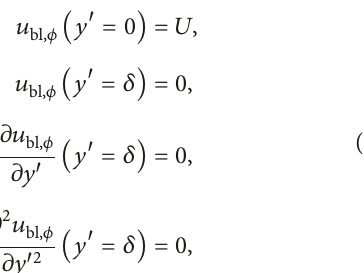
Figure 7 as thin boundary layer overflows a section of low fluid velocities without significant disturbances. However, at the leading edge of downstream pad significant velocity gradients occur. Therefore, maximum pressure within this region is located in the upper right corner comparable to lid driven cavity flow. Black arrows indicate the mayor flow directions in Figure